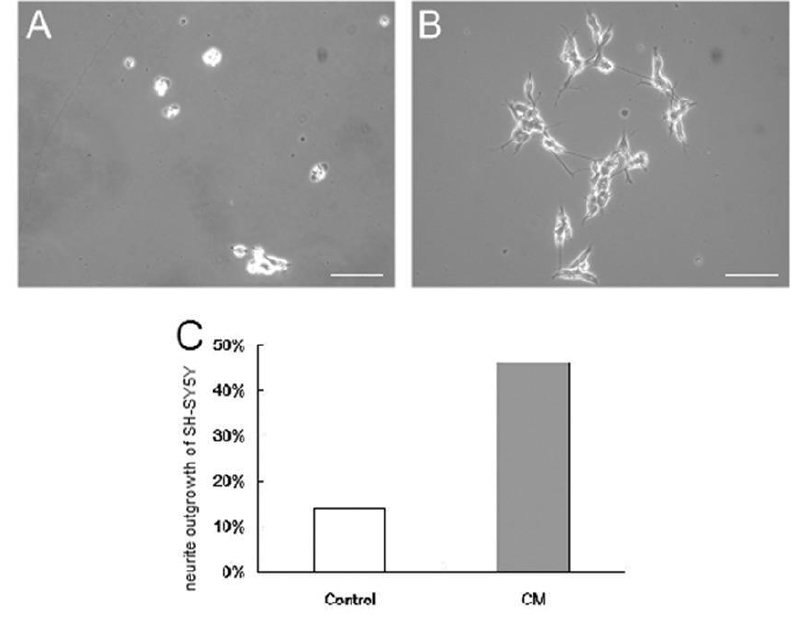
Figure 6. SH-SY5Y cells cultured with the conditioned medium from differentiated placenta-derived multipotent stem cells (PDMCs). The conditioned medium (CM) from Schwann cell-like cells promoted more neurite sprouting from the SH-SY5Y cells ( B ) than did the control group ( A ). The longest length and average length of neurites were also greater in the CM group ( B ). The neurite outgrowth of SH-SY5Y cells was 14.03% in the control group and 46.38% in the CM group ( C ). Bar, 100 μ m.